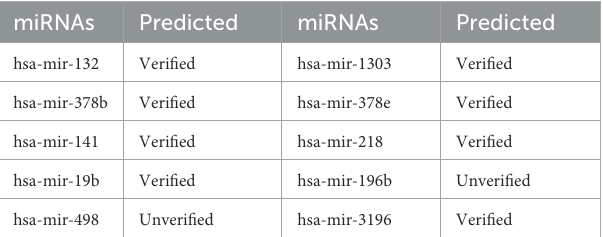
TABLE 4 A case study of the association of disease named Carcinoma, Renal Cell with various miRNAs.